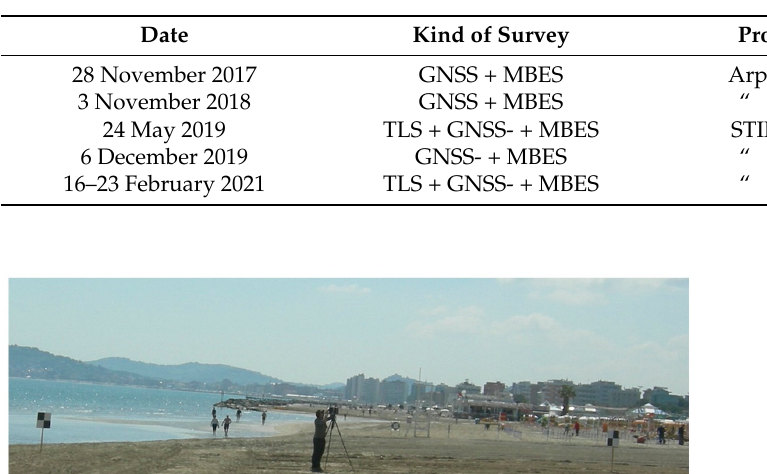
Table 1. List of surveys carried out in the Riccione area.